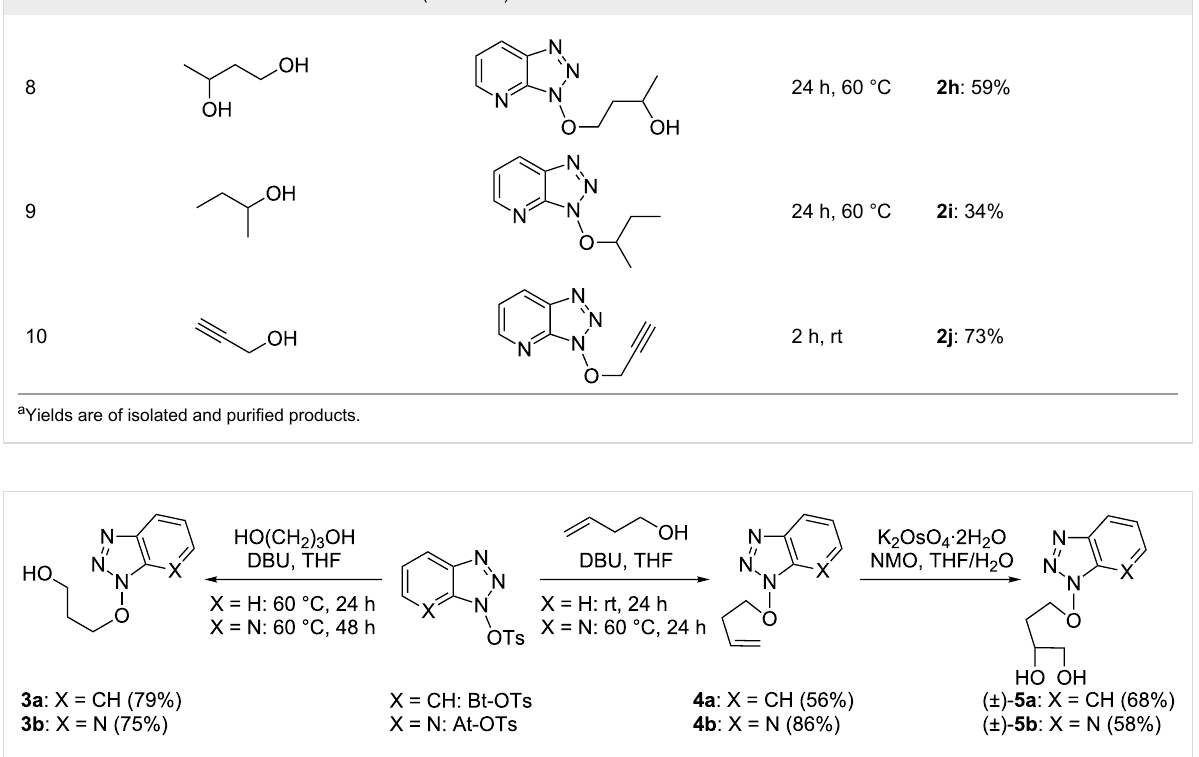
Table 4: Reactions of various alcohols with At-OTs.